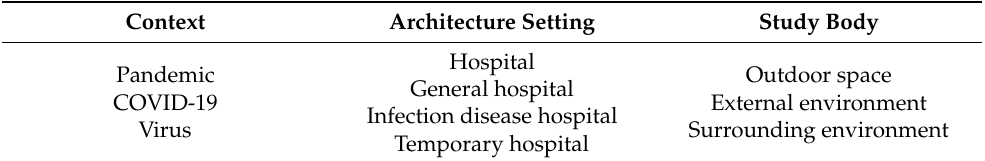
Table 1. Triangle Combinations of Keywords for Web